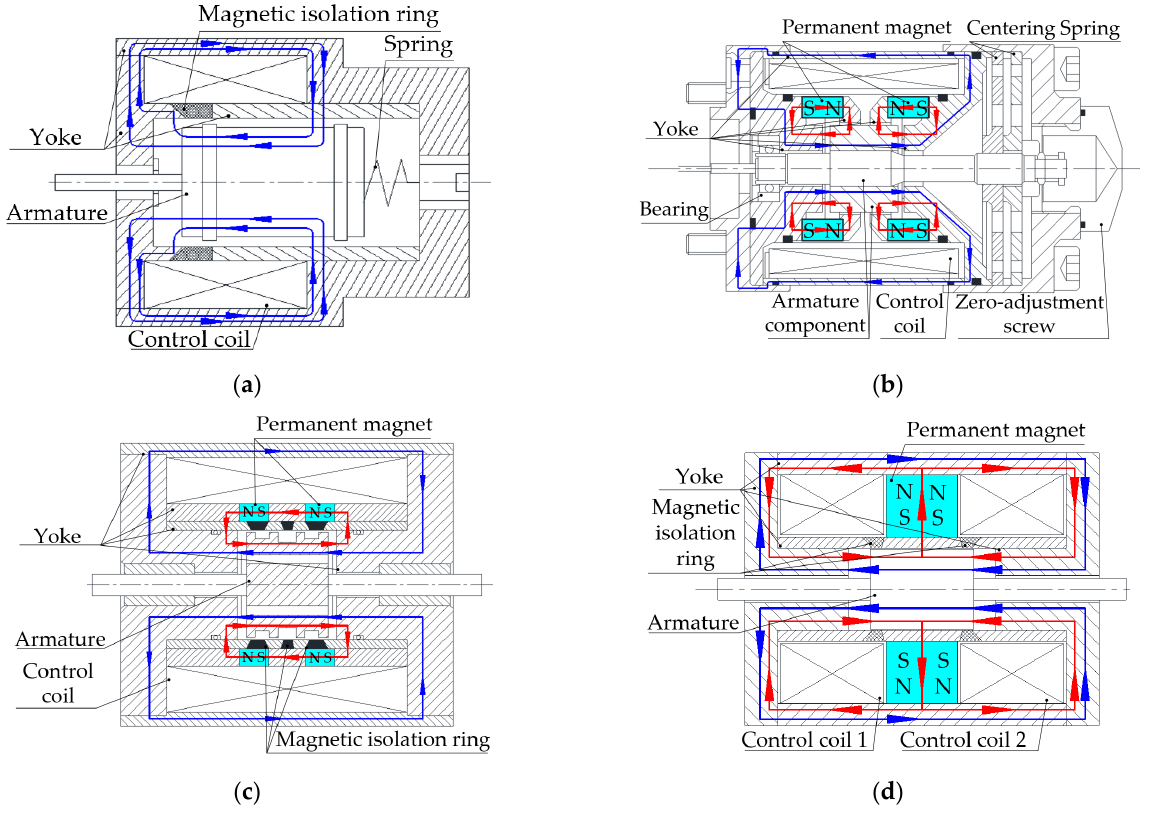
Figure 1. Four different magnetic circuit topologies. ( a ) The proportional solenoid; ( b ) Moog’s LFM; ( c ) Li’s LFM; ( d ) Ding’s LFM.